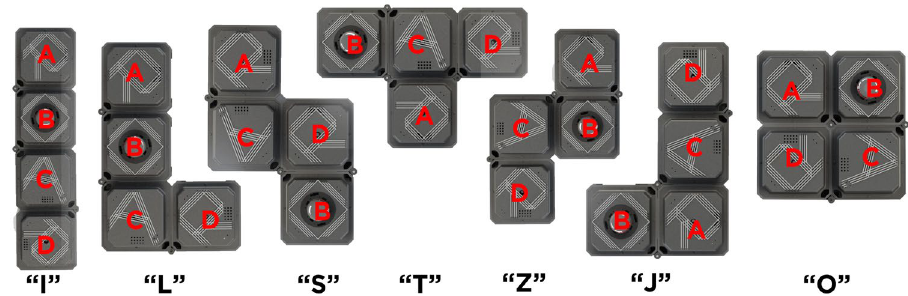
Figure 3. Seven configurations of hTetro.